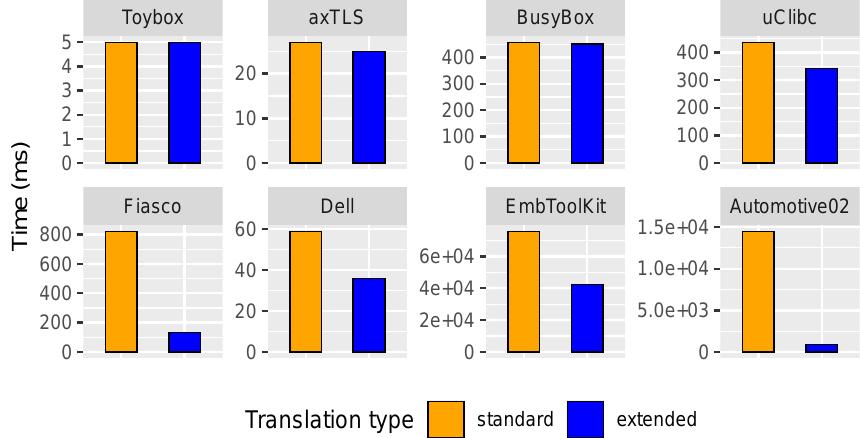
Figure 11. Translation times to standard and extended logic